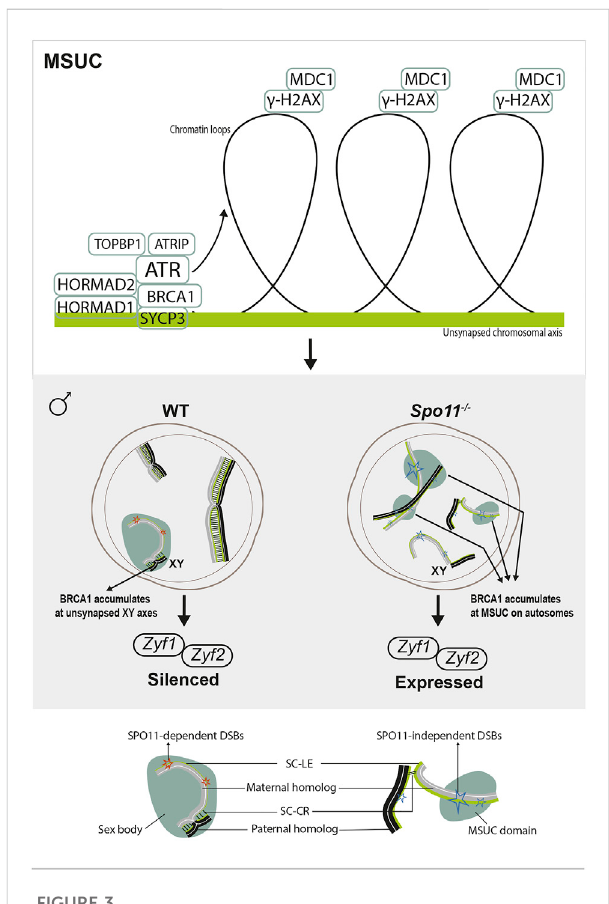
Meiotic response to asynapsis in male. Upper panel, meiotic silencing of the unsynapsed chromatin (MSUC). Axially located proteins signal asynapsis and recruit ATR with cofactors, such as BRCA1.Ifasynapsispersists,ATRtranslocatestochromatinloops, phosphorylating H2AX ( γ H2AX). This signaling spreads all over the chromatin with the help of MDC1, leading to the recruitment of silencing factors for the irreversible silencing of this region. Lower panel, in wild-type spermatocytes, the physiological MSUC occurs at XY chromosomes (MSCI), resulting in the silencing of sex chromosome-linkedlethalgenes( Zfy1 and Zfy2 ) . However,in Spo11 − / − spermatocytes, despite extensive asynapsis, localized MSUC are triggered by SPO11-independent DSBs on unsynapsed autosomes. As BRCA1 accumulates at these DSB sites, MSCI fails to form, and lethal genes are